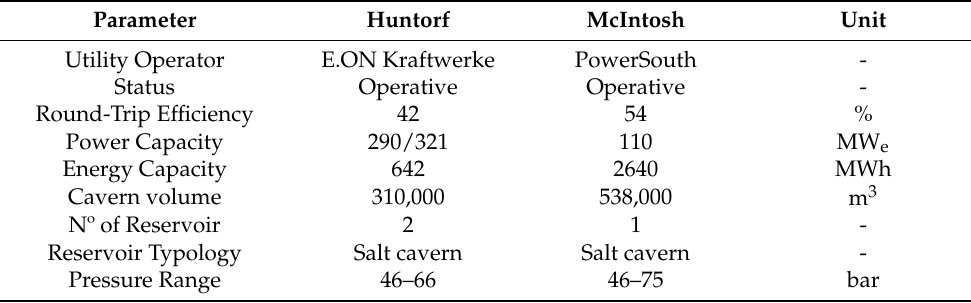
Figure 2. Timeline of cornerstones in CAES R&D. Table 1. Key technical parameters of Huntorf and McIntosh D-CAES plants ([6,17,19]).